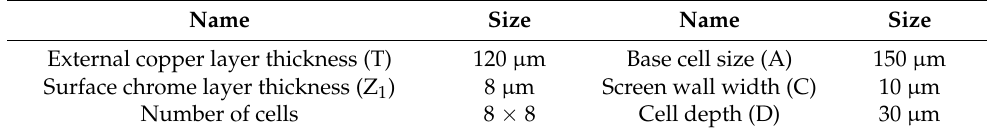
Table 1. Model initial parameters.